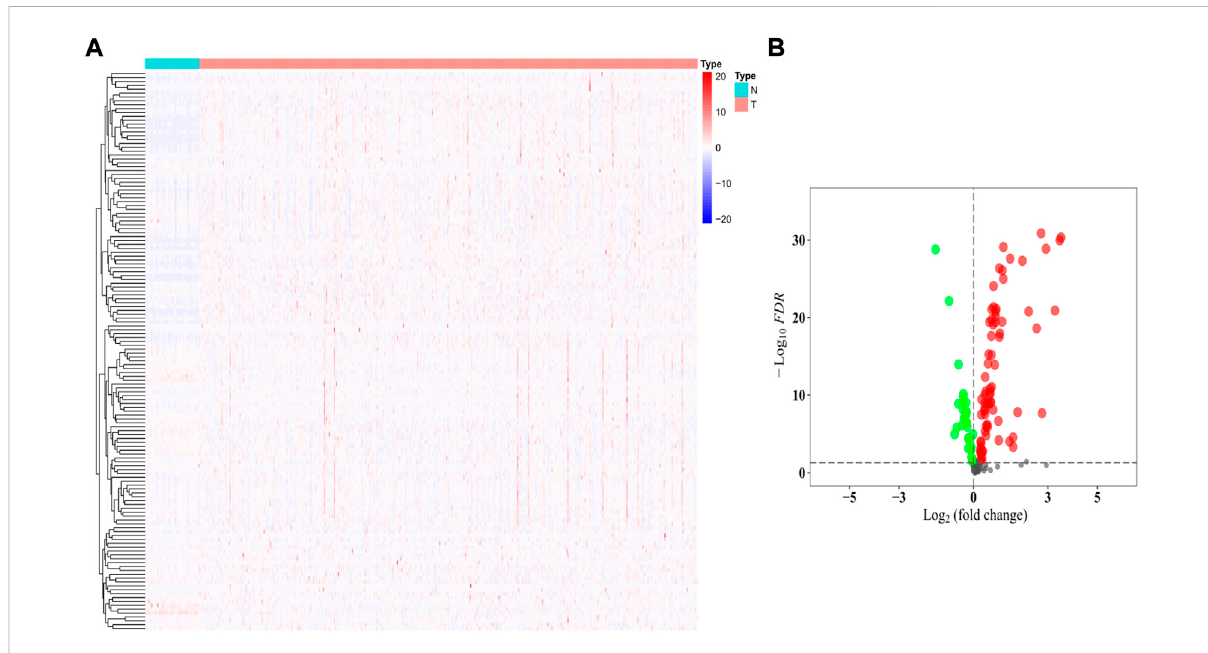
FIGURE 3 Identi fi cation of the DEGs between normal and tumor samples. (A) Heatmap of the 144 HMMRs between normal (N) and tumor tissues (T); (B) Volcano plot showing the DEGs (green dots: downregulated at least 2-fold in tumor tissues; red dots: upregulated at least 2-fold in tumor tissues).